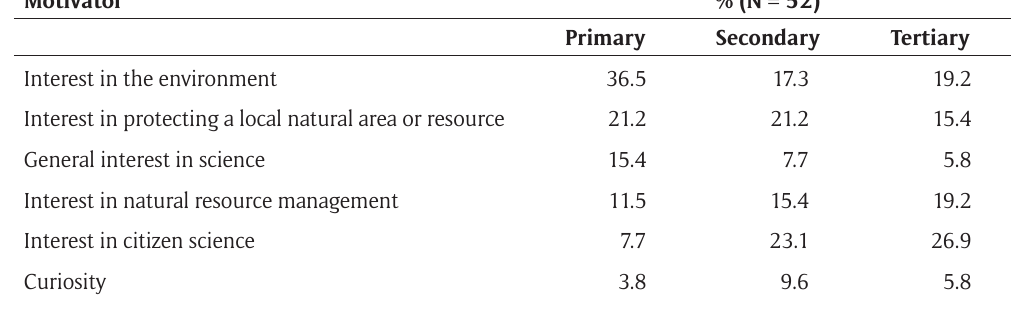
Table 3: Volunteer’s rankings of potential motivations to participate in the